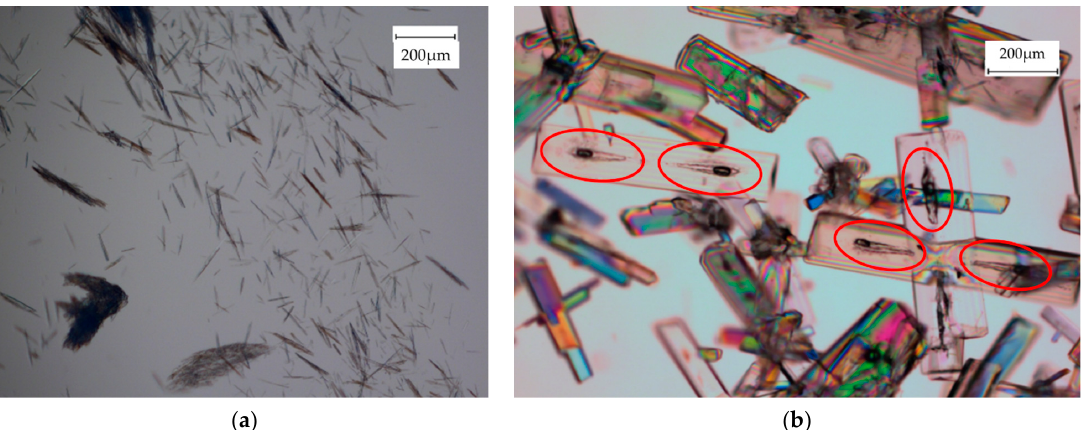
Figure 2. Crystals of S-IBU/S- α MBA obtained from a direct resolution. ( a ) Crystallization performed in ethanol; ( b ) crys- tallization performed in a mixture: ethanol–water (80/20 w/w ) and a supersaturation: β = 1.8 at 20 °C; seeding at 40 °C. Encircled in red the symmetrical fluid inclusions.